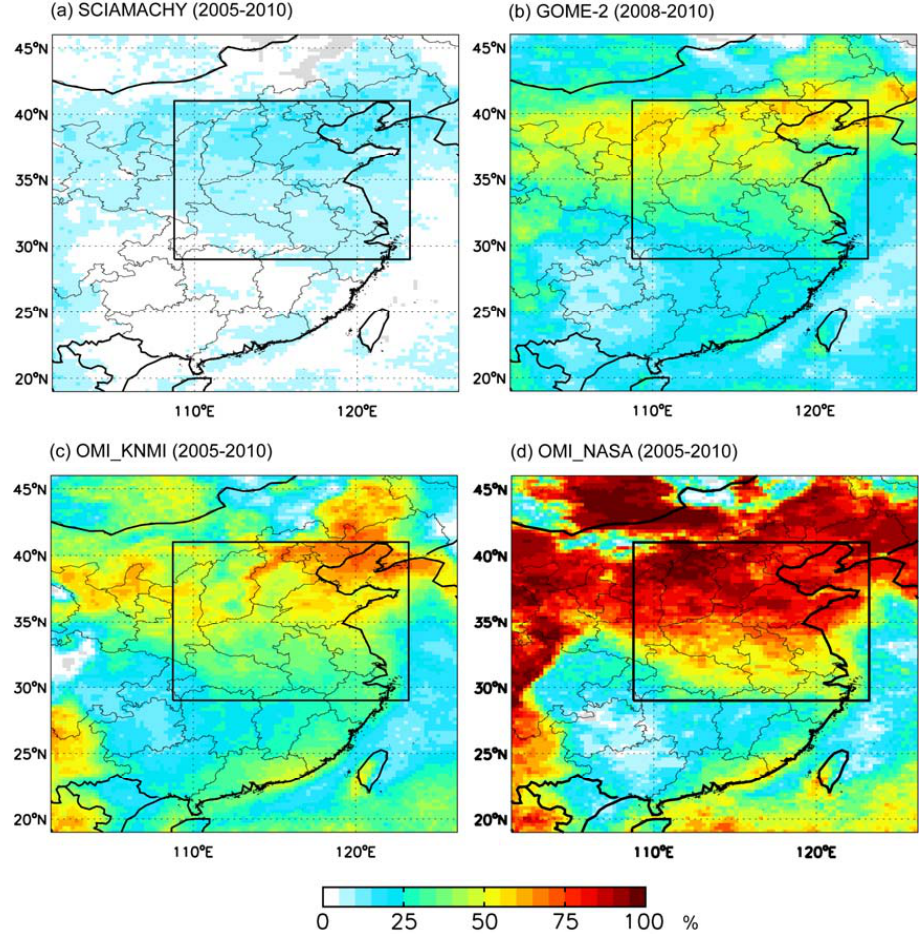
Fig. 2. The percentage of days in January with valid data averaged over 2005–2010 in the four retrieval products. OMI NASA has more coverage than OMI KNMI because of weaker criteria for cloud screening. Also shown is boundary specifications (black lines) of Northern East China analyzed in this